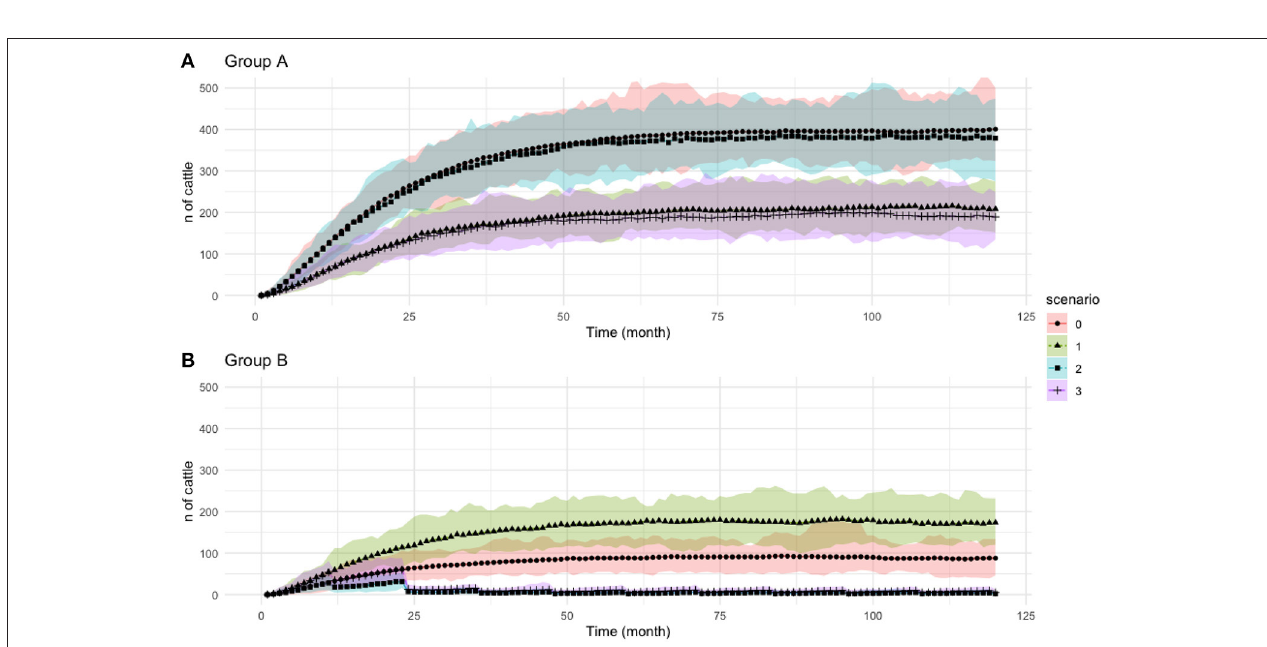
FIGURE 6 | Population of transiently infected (TI) animals over time. (A) Population in Group A. (B) Population in Group B. Legend color and shape showed different scenarios for each group. Scenario 0 represent baseline scenario. The y -axis is the number of cattle and x -axis is monthly time step. Note that the axis scale in this figure is different from Figure 5